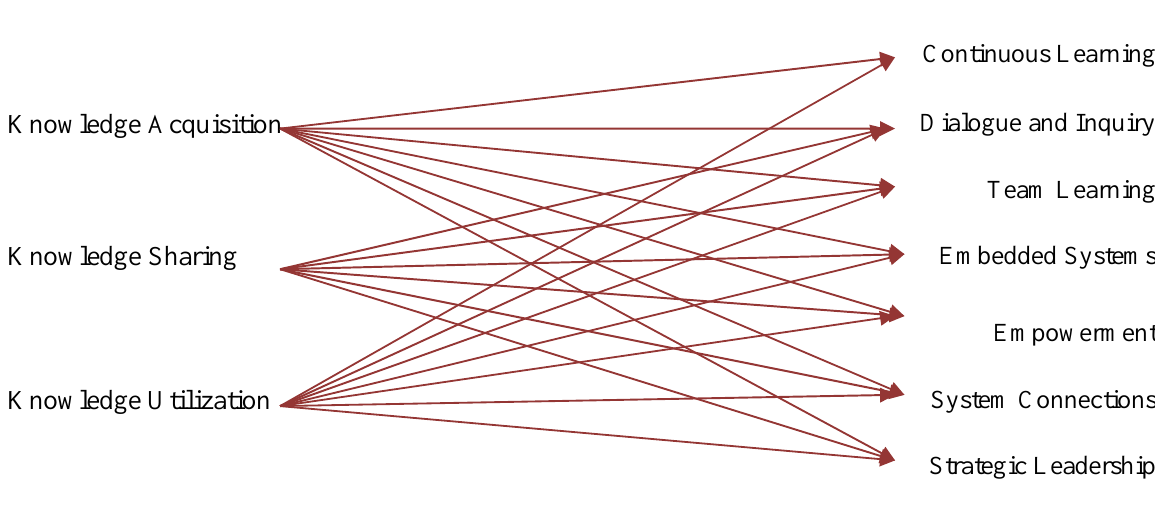
, H , H , H , H , H and H 4 5 6 7 8 9